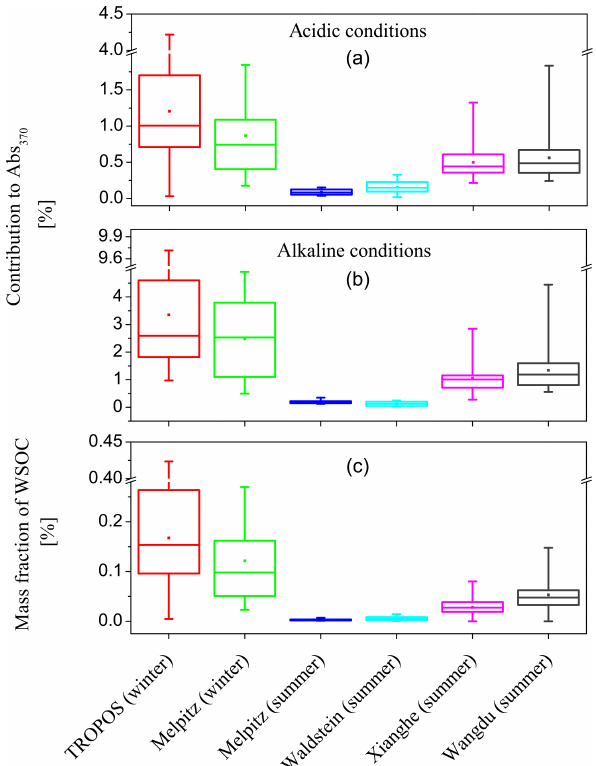
Figure 4. Top and center: contribution of the sum of NACs to the aqueous extract light absorption at each site under acidic (a) and alkaline (b) conditions. Bottom: mass contributions of the sum of NACs to the WSOC (c)